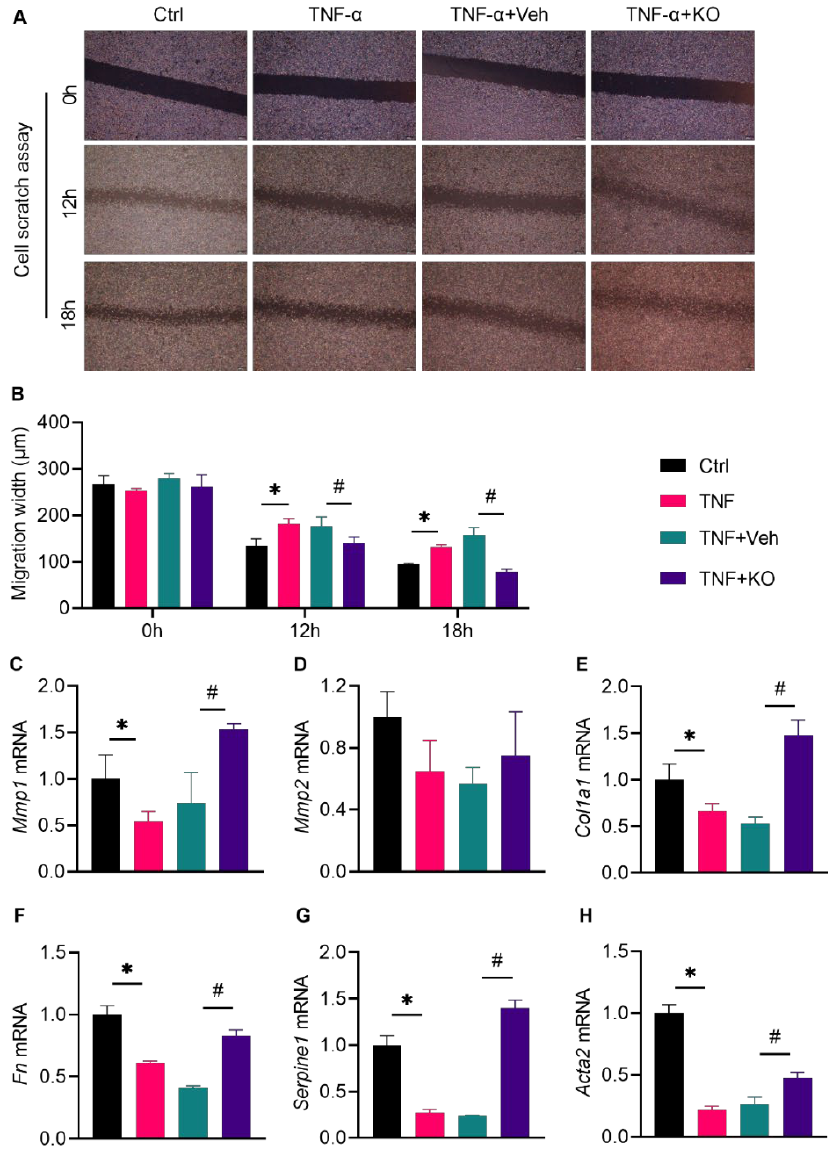
Figure 6. KO promoted the profibrotic transition of the TNF- α -stimulated fibroblasts. ( A ) A cell scratch assay was performed to assess the migrating activity of L929 cells treated with TNF- α , with the ( B ) migration width measured and quantified. ( C ) The Mmp1 mRNA levels, ( D ) Mmp2 mRNA levels, ( E ) Col1a1 mRNA levels, ( F ) Fn mRNA levels, ( G ) Serpine1 mRNA levels, and ( H ) Acta2 mRNA levels were determined. The data were summarized as means ± SD. *, p < 0.05 vs. Ctrl; #, p < 0.05 vs. DM. Col1α1 , collagen 1 α 1; Fn , fibronectin; Mmp1 , matrix metalloproteinase 1; Mmp2 , matrix metalloproteinase 2; Serpine1 , serine (or cysteine) peptidase inhibitor 1. The other abbreviations are the same as in Figure 5.